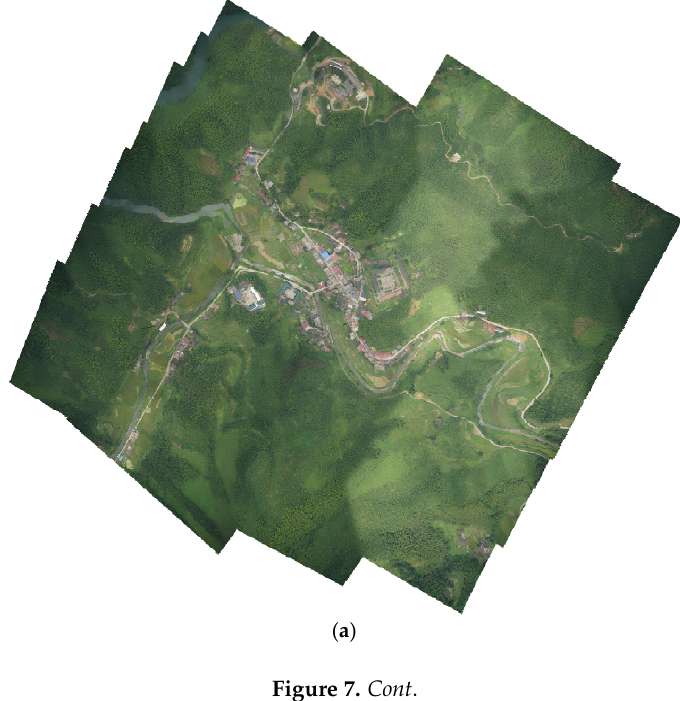
Figure 7. Cont. Figure 7. Cont.